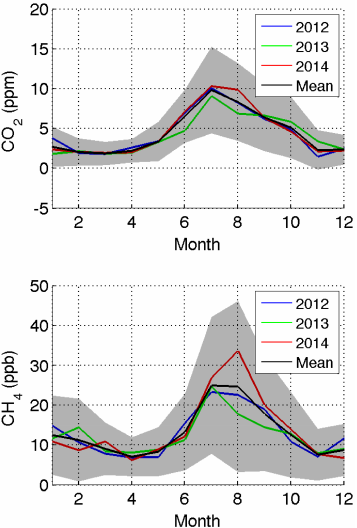
Figure 3. Magnitude of land surface influence on the tower measurements, in ppm(µmolm − 2 s − 1 ) − 1 , for average monthly midafternoon footprints from the WRF-STILT model for 2012 (top), 2013 (middle), and 2014 (bottom). Colors, as indicated in the figure legend, show the average monthly surface influence of Lower Alaska (defined as any part of Alaska south of the Brooks Range, i.e., not part of the North Slope), Canada, Eurasia, and the North Slope of